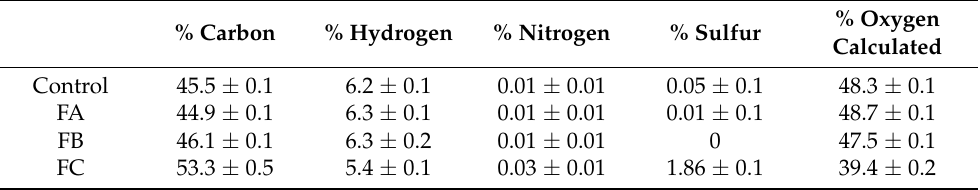
Table 4. Percentage of C, H, N, S, O elements (% mg) in fractions of non-destructive Van Soest method and control. Number of repetitions =